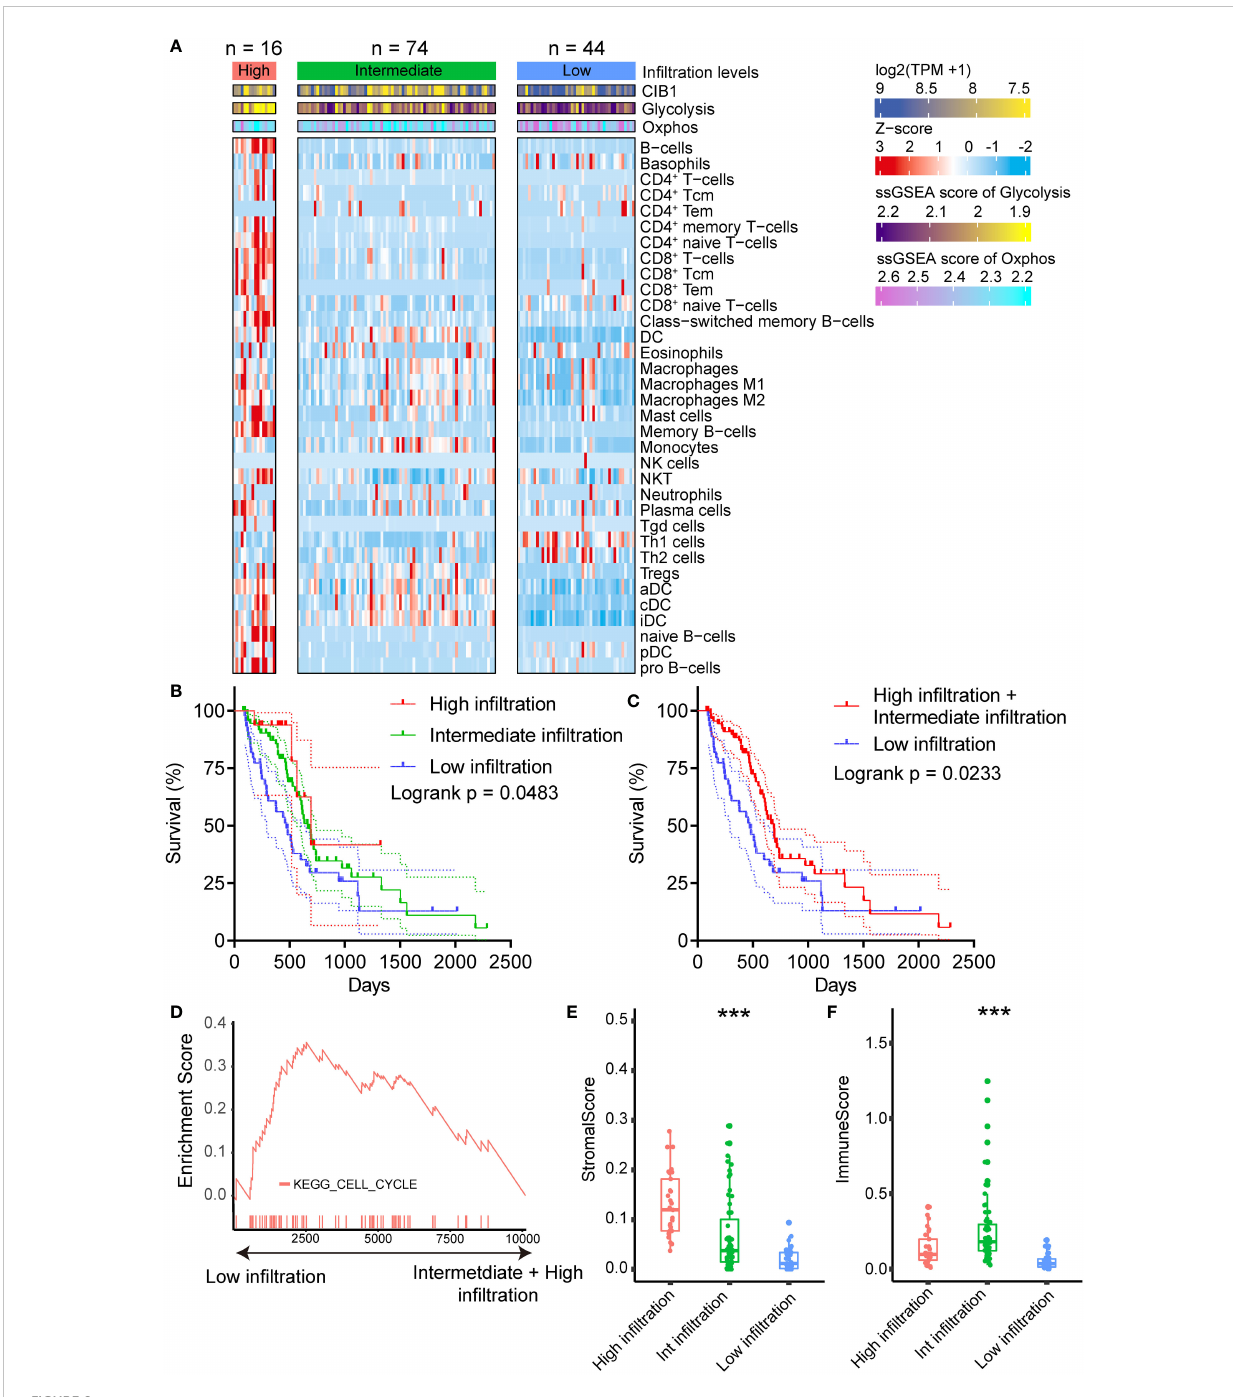
FIGURE 2 CIB1-related metabolism reprogramming suppressed immune cell in fi ltration in PDAC. (A) Heatmap representation of the three in fi ltration levels of immune cells in PDAC. The annotation bars indicated the clusters generated by NMF, CIB1 expression and ssGSEA score of Oxphos and Glycolysis. (B, C) Survival plots of patients with different immune cell in fi ltration levels in TCGA cohort. (D) Up-regulation KEGG pathways in samples with a low immune cell in fi ltration level. (E) Comparison of stromal scores between the in fi ltration levels of immune cells in PDAC. (F) Comparison of the immune score between patients with PDAC with three levels of in fi ltrating immune cells. *p< 0.05, **p< 0.01, ***p<